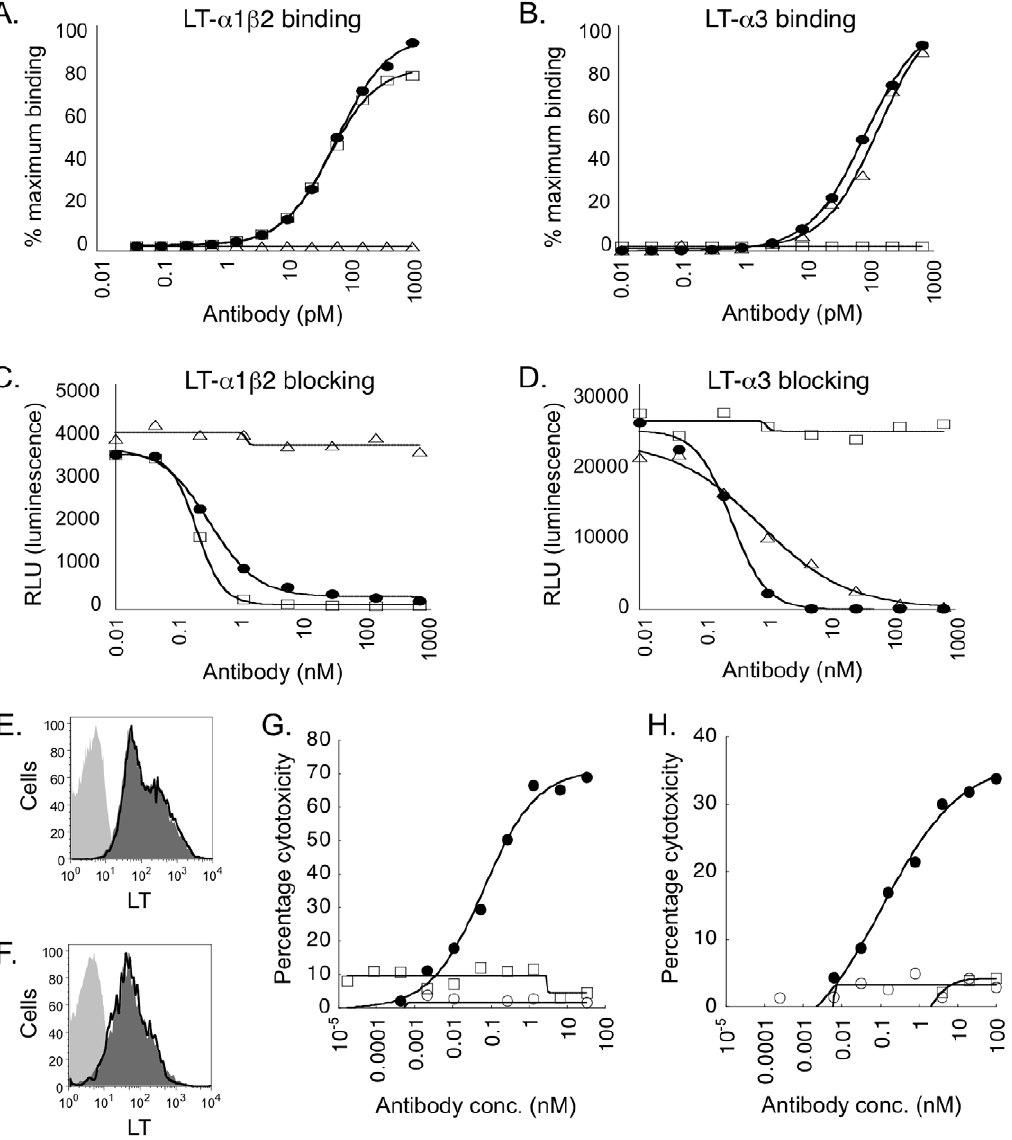
Figure 3. Binding, blocking and depleting properties of anti-LT- a mAb. A . Anti-LT- a MLTA3698A (filled circles) LT- b R.Ig (open squares) and TNFRII.Ig (open triangles) binding to LT- a 1 b 2 in ELISA binding assays. B . ELISA binding to LT- a 3. C . Blockade of LT- b R.Fc binding to LT- a 1 b 2 in ELISA competition assays with anti-LT- a MLTA3698A (filled circles), LT- b R.Ig (open squares) or TNFRII.Ig (open triangles). D . Blockade of TNFRII.Fc binding to LT- a 3 in ELISA competition assays. ADCC activity of anti-LT- a mAb against LT-expressing cells. LT expression on 293-hLT- ab cells ( E ) and activated human CD4 + T cells ( F ) was detected using anti-LT- a MLTA3698A (dark gray shaded histograms), anti-LT- a -FcMT mAb (solid line). Isotype control antibody staining is indicated by light-shaded histograms. Data are representative of at least five experiments. ADCC activity against 293-hLT- ab ( G ) or activated CD4 + T cell ( H ) targets mediated by MLTA3698A (filled circles) or anti-LT- a -FcMT(open circles). Isotype control mAb is indicated by open squares. Data are representative of three experiments.